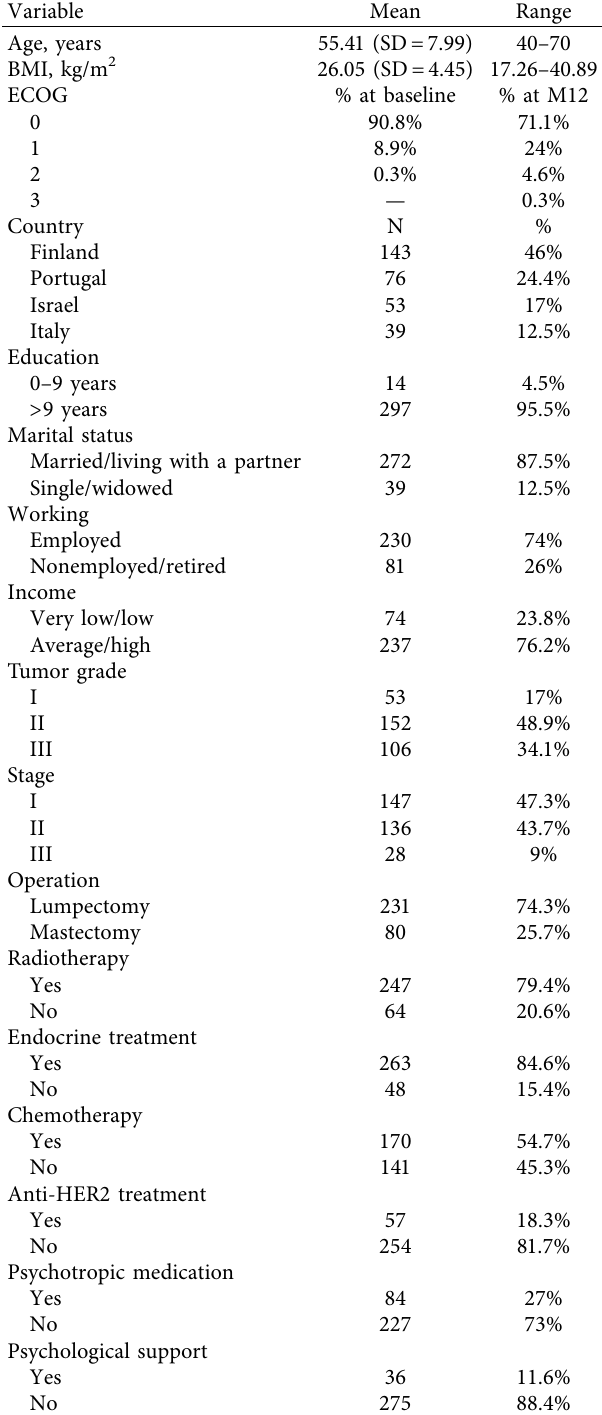
Table 1: Patient characteristics n �